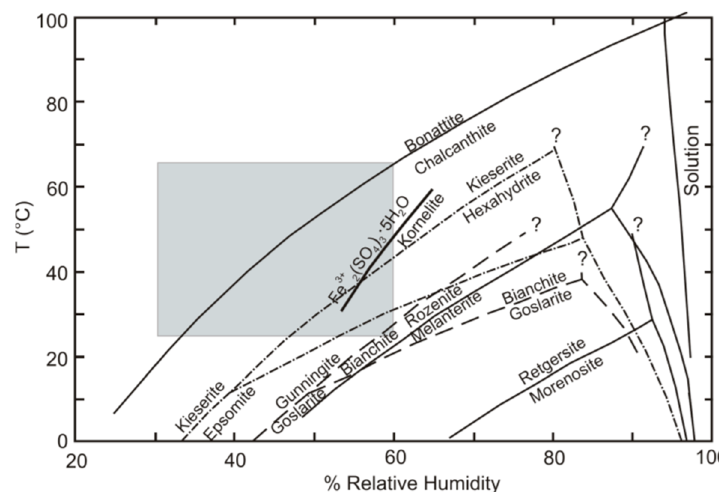
Figure 8. Diagram showing the location of dehydration reactions, in terms of temperature and relative humidity, for the simple sulfate systems that were investigated experimentally, using the humidity-bu ff er technique [17]. The gray field shows the range of temperature conditions for the laboratory experiments in this article (25–60 ◦ C). The humidity values correspond to [33].